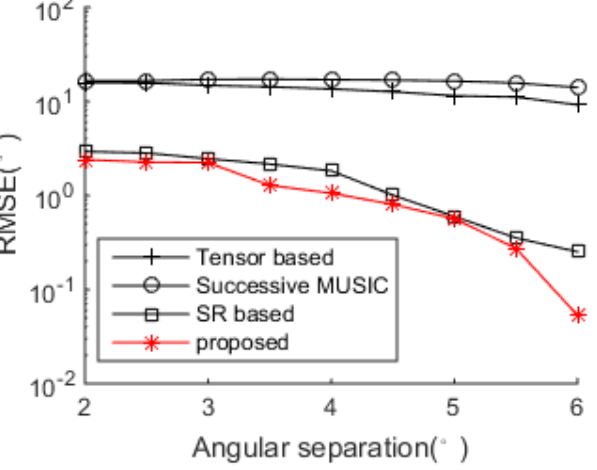
Figure 9. DOA estimation performance comparison versus angular separation (SNR = 5 dB).